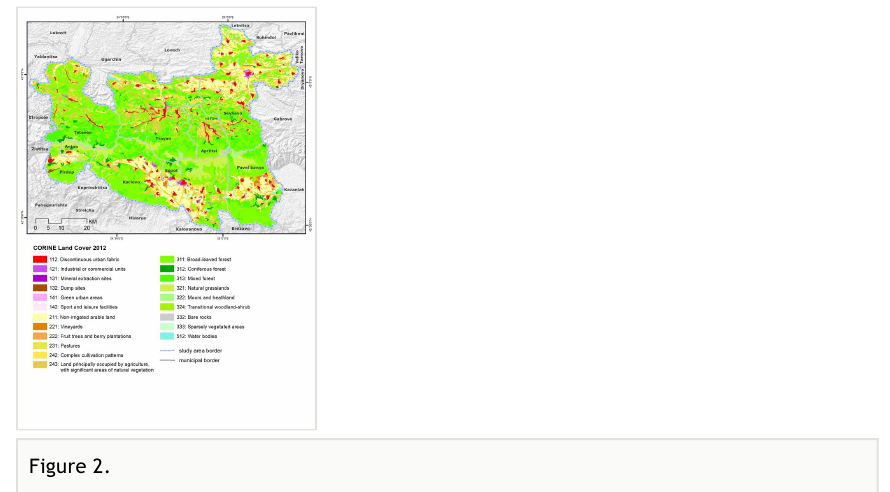
Map of the CLC12 for the case study area, Central Balkan National